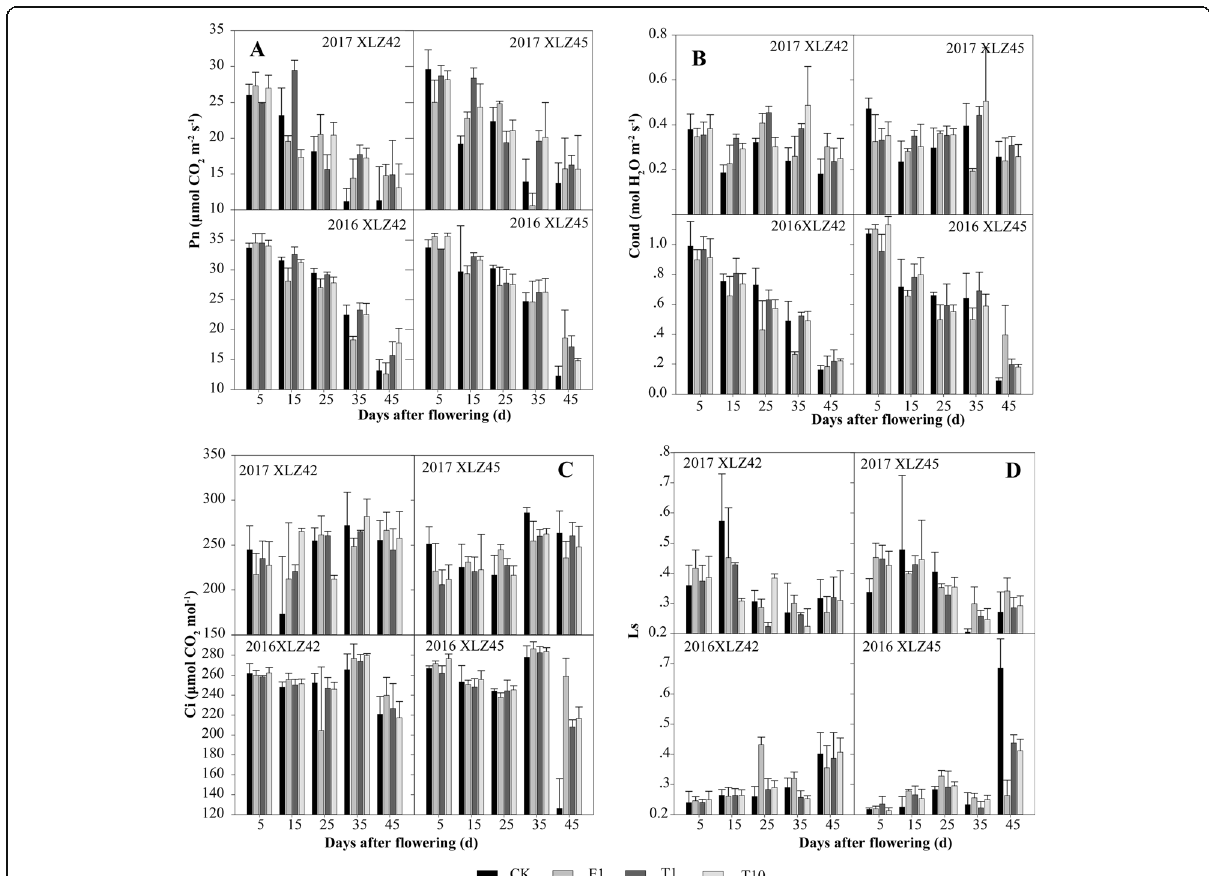
Fig. 4 Gas exchange parameters of cotton varieties (XLZ42 and XLZ45) at different days since flowering in various treatment groups: 1 (T1) and 10 days (T10) before the first irrigation, respectively, and 1 day before the second irrigation (E1) after seedling emergence during 2016 – 2017. The control group (CK) had film mulching throughout the growth stages. Bars are means ± standard deviation ( n = 3). Pn, photosynthetic rate; Cond, conductance to H 2 O; Ci, intercellular CO2 concentration; Ls, stoma limit value